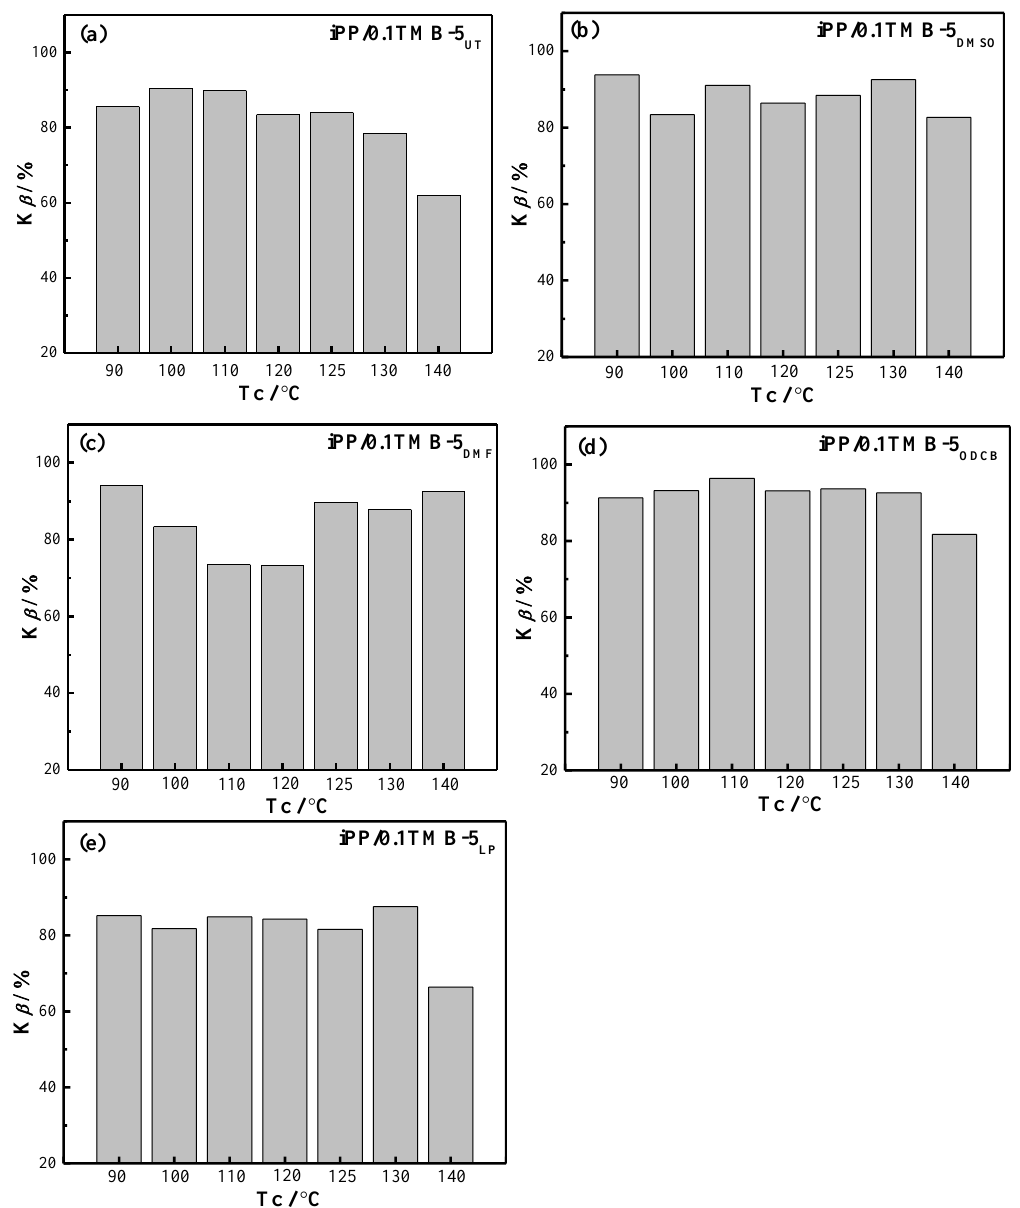
Figure 3. K β values of different TMB-5 nucleated iPP specimens: ( a ) iPP/0.1TMB-5 UT , ( b ) iPP/0.1TMB-5 DMSO , ( c ) iPP/0.1TMB-5 DMF , ( d ) iPP/0.1TMB-5 ODCB and ( e ) iPP/0.1TMB-5 LP which have statically crystallized at different temperatures, the NA content is 0.1 wt%.